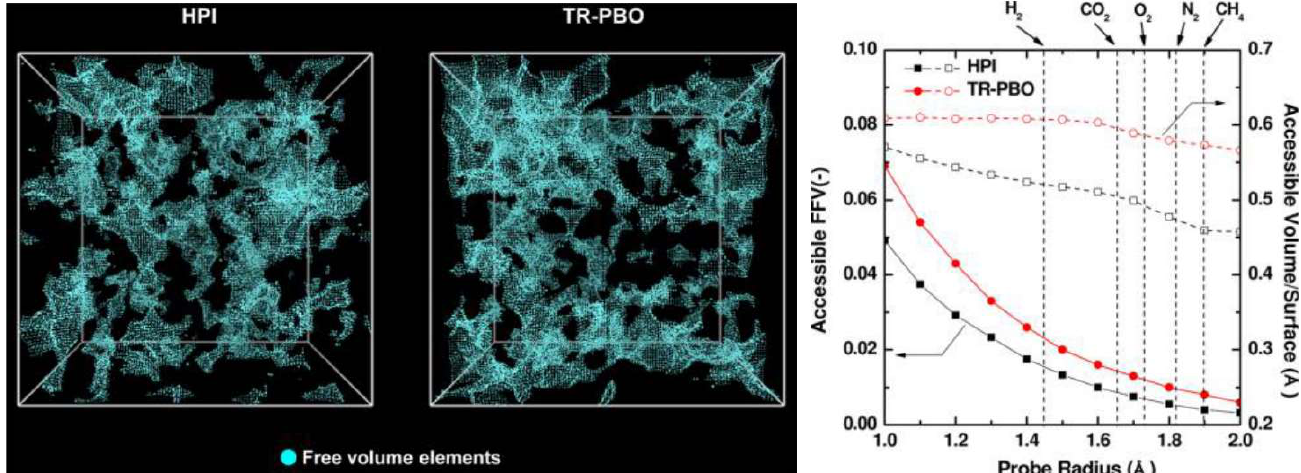
Figure 22. Simulated free-volume distribution of a low-FFV polyimide (left) and its high-FFV thermally rearranged variant (center). (Right) Fractional free volume (FFV) and ratio of free-volume and surface area with probe radius calculated from kinetic diameters of gas molecules. Reproduced with permission from Ref. [361]. Copyright 2014, American Chemical Society.